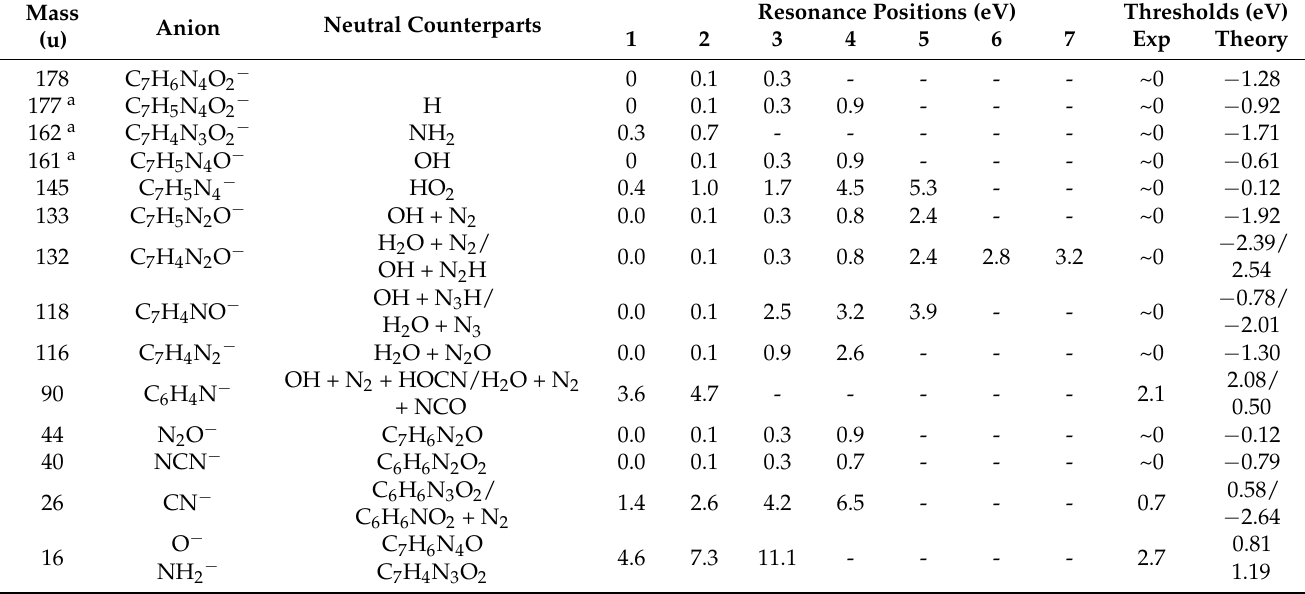
Table 1. Summary of anions observed upon electron attachment to tirapazamine, along with their mass, suggested molecular structure, associated neutral fragment(s), resonance positions, experimental threshold and thermodynamically determined threshold. Energies were calculated at the B3LYP/aug–cc–pVDZ level of theory; suggested neutral fragments are based on theoretical analysis.